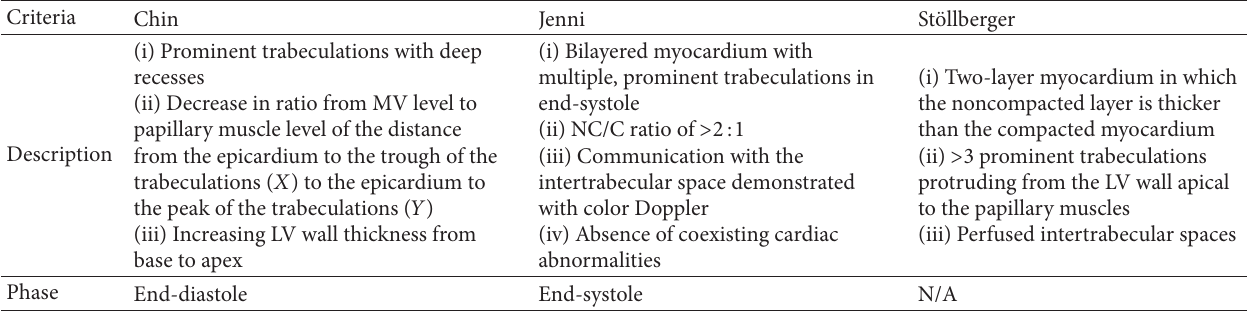
Table 1: Echocardiographic diagnostic